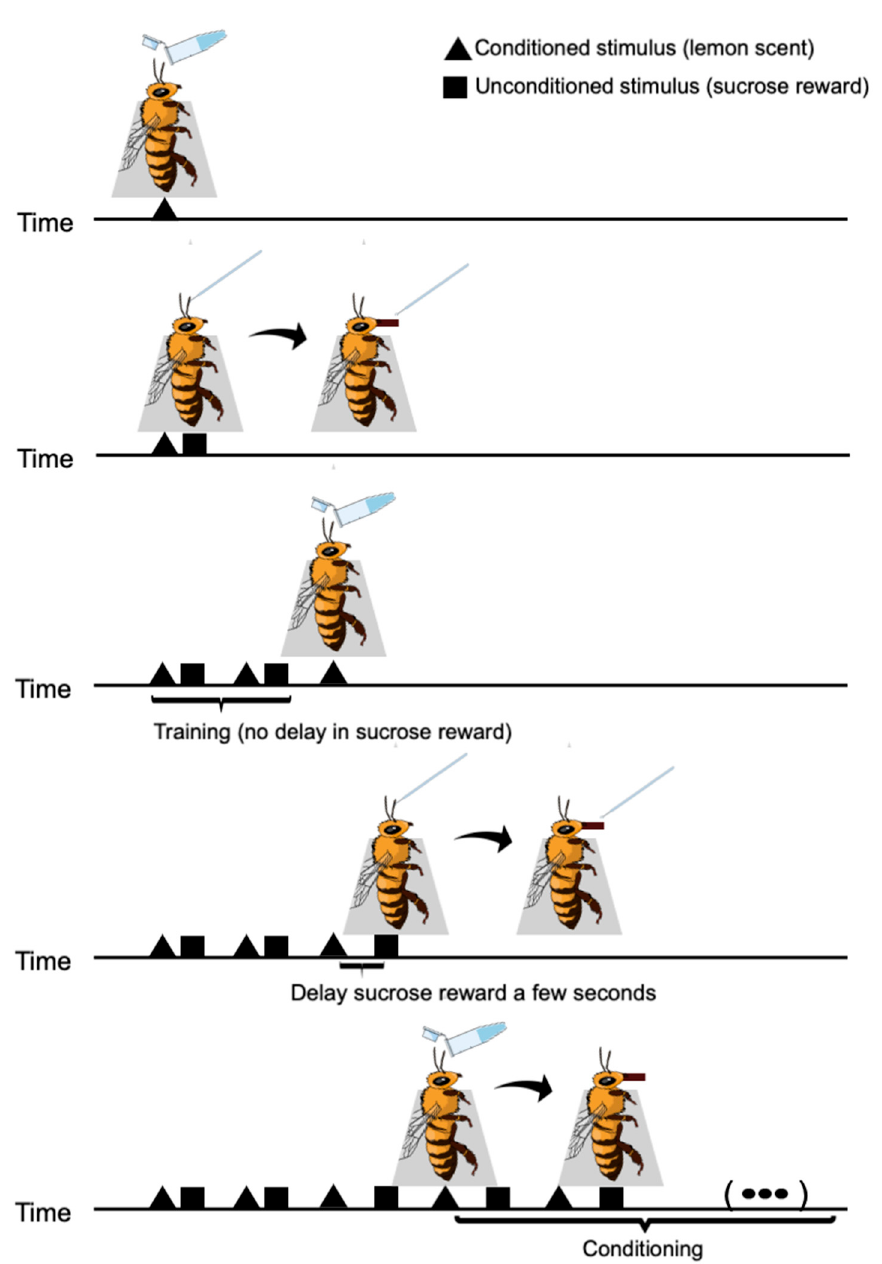
Figure 1. The training schematic for the conditioning of honeybees using a lemon scent. The number of conditioned/unconditioned stimuli cycles can be varied. The conditioning was repeated across all treatments.